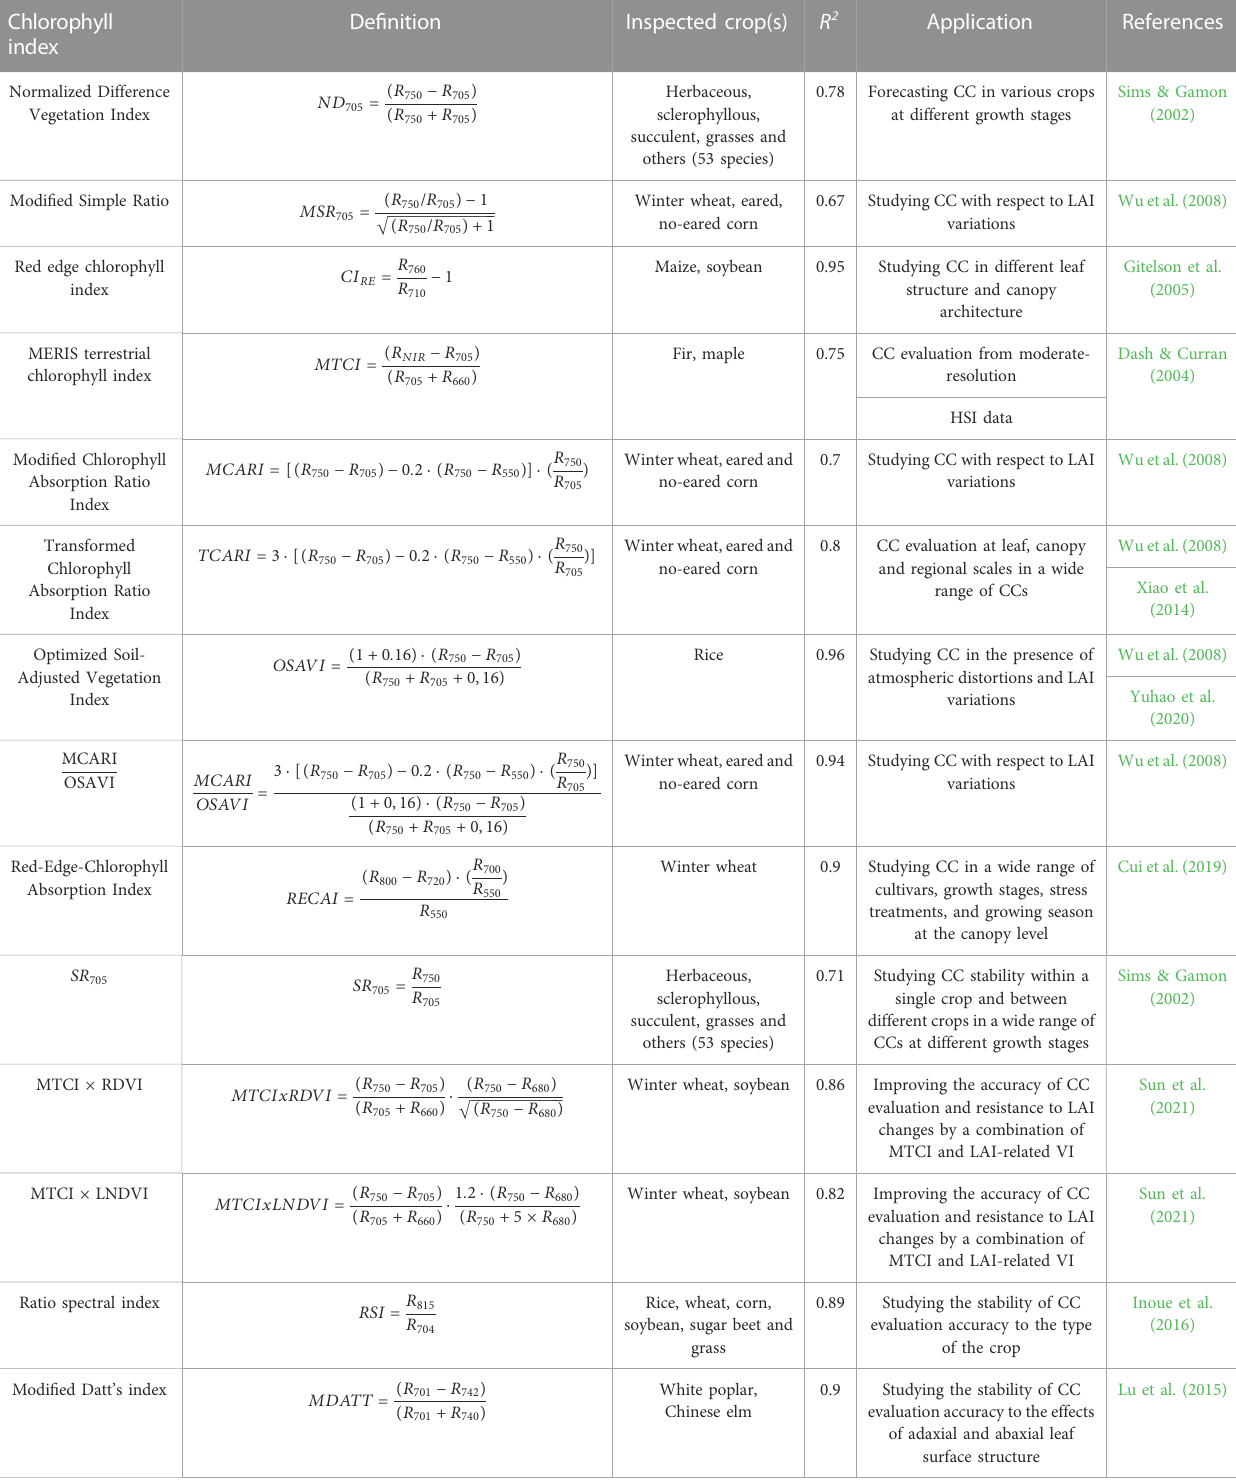
TABLE 3 Selected CIs, their de fi nitions, reported applications and reference